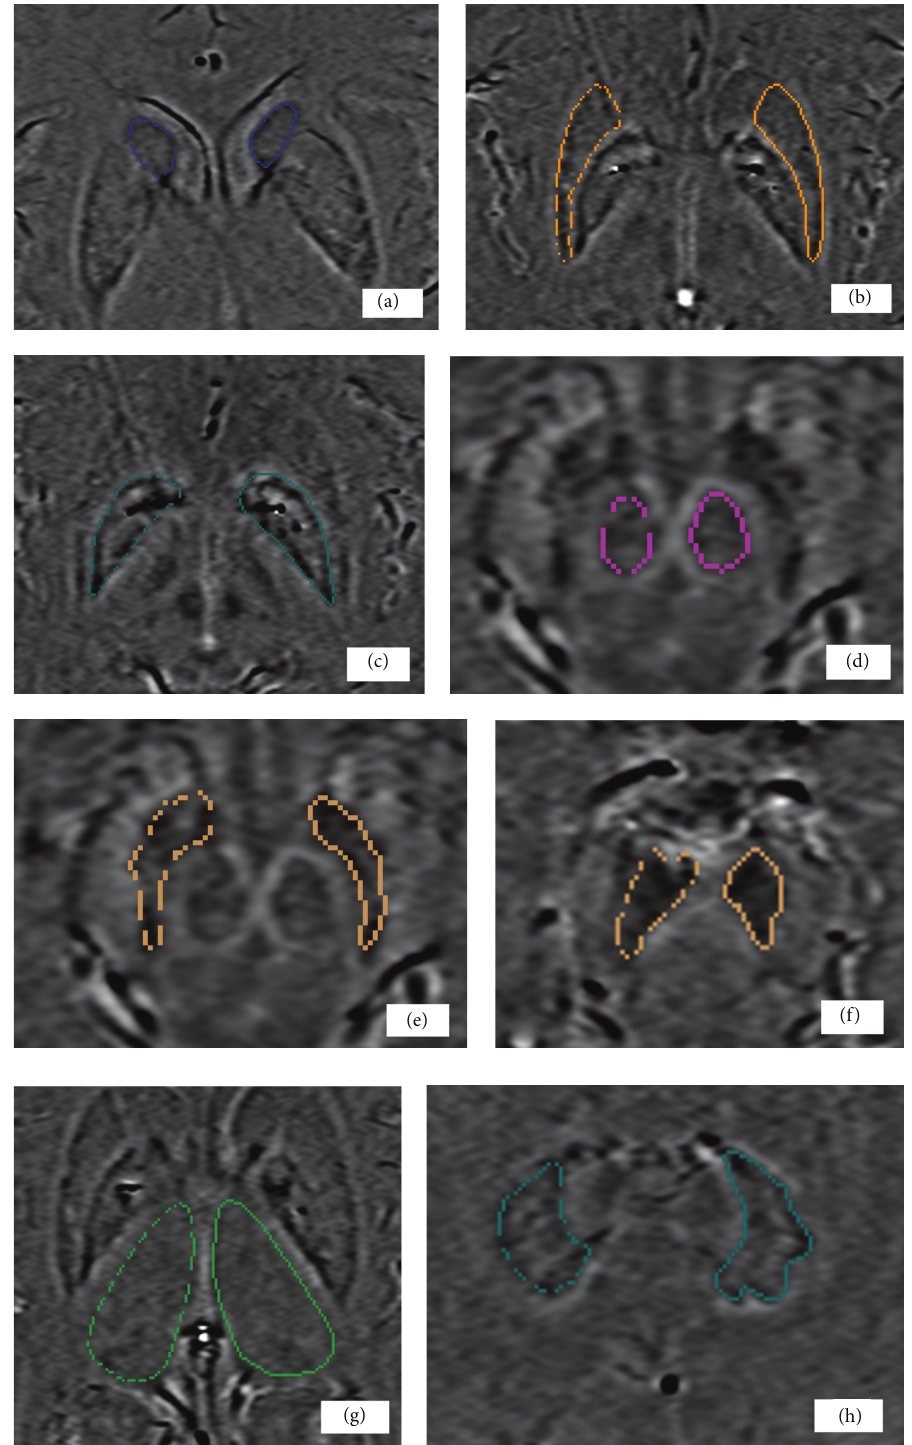
Figure 1: Regions of interest drawn on SWI: CN (a), PUT (b), GP (c), RN (d), SN (e), caudal SN (f), THA (g), and DN (h). CN: caudate nucleus, PUT: putamen, GP: globus pallidus, RN: red nucleus, SN: substantia nigra, caudal SN: caudal substantia nigra, THA: thalamus, and DN: dentate